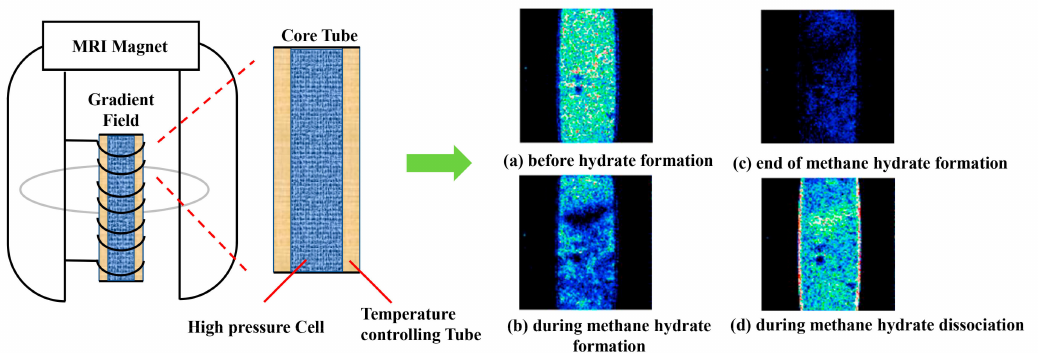
Figure 10. MRI Images during methane hydrate formation and dissociation (( a – d ) adapted from Yang